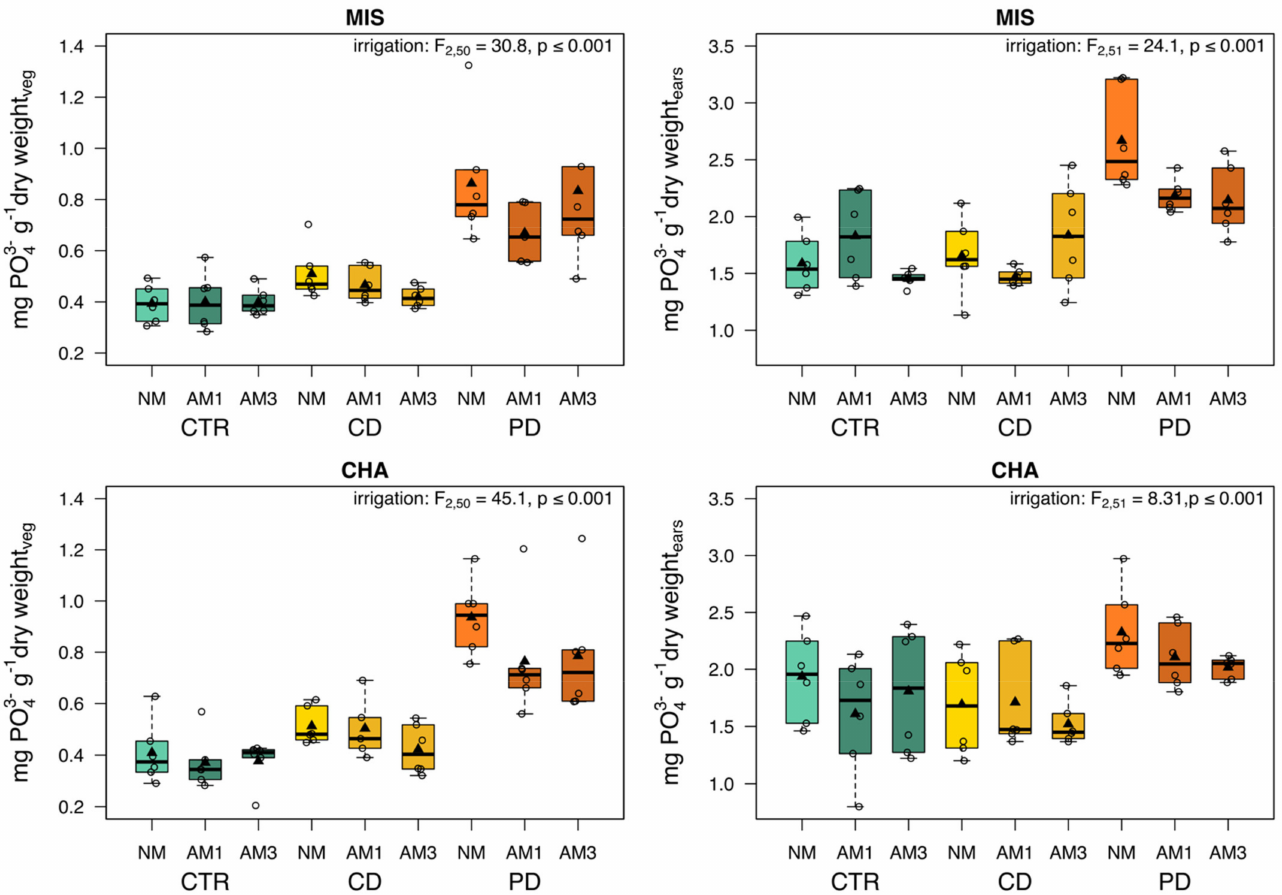
Figure 7. Content of elementary P of vegetative biomass (stems and leaves) and ears from two wheat cultivars [ Triticum aestivum ; Chamsin (CHA), Mistral (MIS)] 67 days post sowing. Cultivation occurred under different irrigation conditions [control (CTR), continuous drought (CD) and pulsed drought (PD), factor: irrigation]. Plants were either non-mycorrhized (NM), mycorrhized with a single fungus (AM1; Rhizoglomus irregulare ) or with a mixture of three fungi (AM3; R. irregulare, Funneliformis mosseae, F. caledonium ) (factor: substrate). Data are given as box–whisker plots with interquartile ranges (IQR; boxes) including medians (horizontal lines), means (triangles) and whiskers (extending to the most extreme data points with maximum 1.5 times the IQR); individual values are given as open circles. The results of linear models are shown comprising the remaining significant terms after model simplification; n =